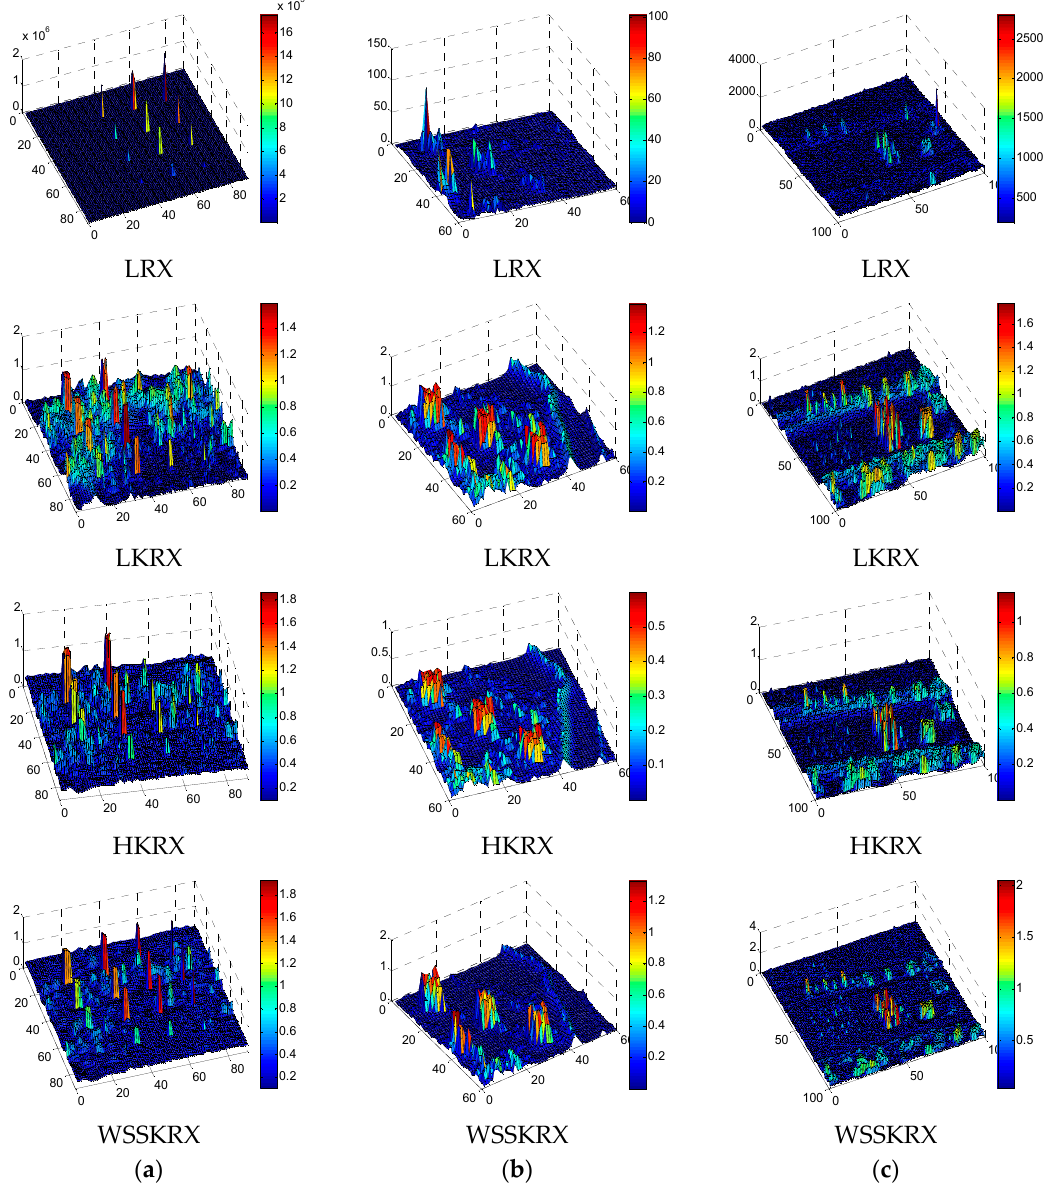
Figure 14. The 3D plots detection results of GRX, LRX, LKRX, HKRX and WSSKRX on three datasets. ( a ) The 3D plots of synthetic dataset; ( b ) The 3D plots of San Diego Airport dataset; ( c ) The 3D plots of SpecTIR dataset.